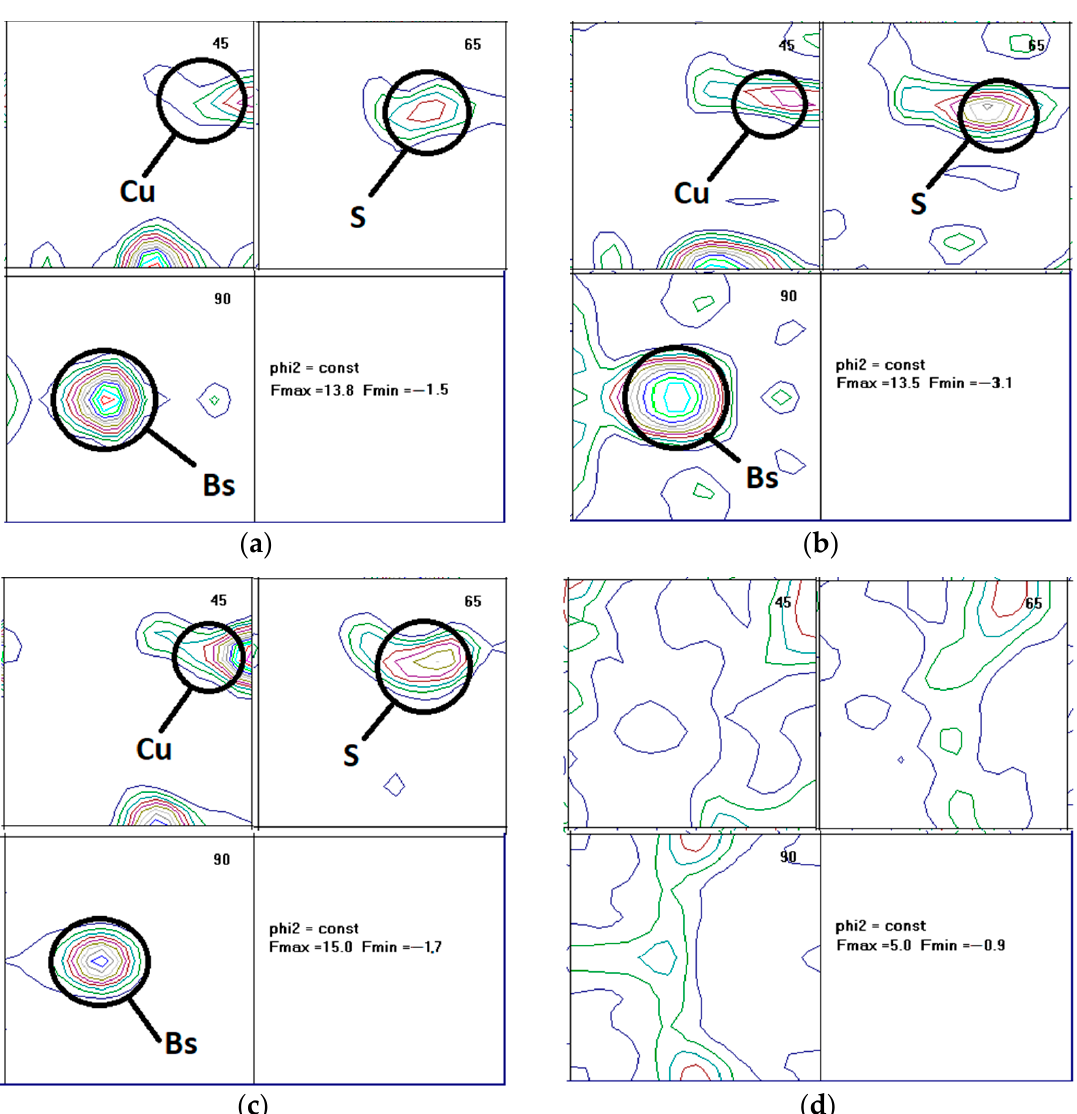
( d ) Figure 5. ODF , aluminum 99.95% (for composition refer to Table 1) compressed under plain strain to 80% engineering strain ( a ) strain rate 1 s − 1 , temperature 300 °C, ( b ) strain rate 1 s − 1 , temperature 450 °C, ( c ) strain rate 10 s − 1 , temperature 300 °C ( d ) strain rate 10 s − 1 , temperature 450 °C. Such a pattern is explained by a decrease in strain hardening with temperature rise, while the brass-type texture-associated slip systems once again become favorable. In ad- dition, a small volume of cube texture appears, as the result of a small number of fine recrystallized grains. The general feature, specific for this alloy, consists in the deployment of slip systems, associated with Cu and S texture components and—to a lesser degree— with the brass texture component Bs. It should be noted that commercially pure alumi- num features a high stacking fault energy, which brings it closer to copper with respect to texture formation. During АМ g1 hot deformation at 1 s − 1 strain rate and 300 °C temperature (Figure 6a), all three β -fiber texture specific components, i.e., Cu, S and Bs, are observed. At the same time, unlike the previous alloy, it shows a strongly pronounced Bs texture component, while the other two rolling texture components are less pronounced. A temperature rise